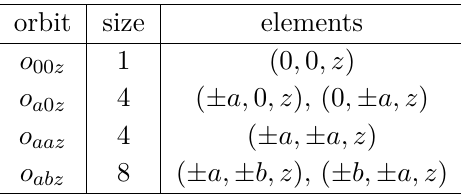
Table 5. Orbit types for the frame with d ref = (0 , 0 , n ) , where n 6 = 0 . Notation as in table 4, with 0 < a < b , and z an unconstrained integer (which may be positive, negative, or zero).